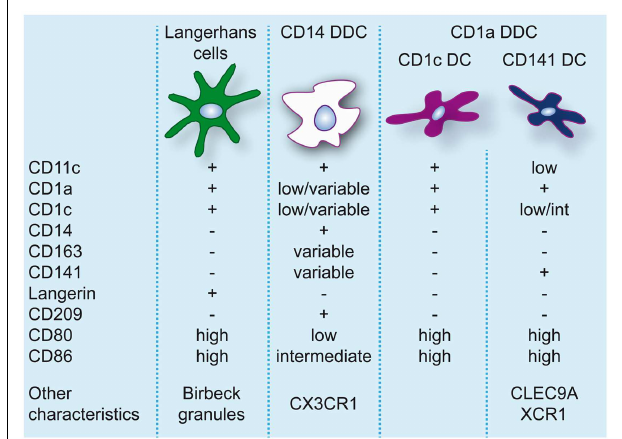
FIGURE 2 | Dendritic cell populations in human skin during steady-state conditions . Expression levels of markers commonly used to identify and discern these populations are